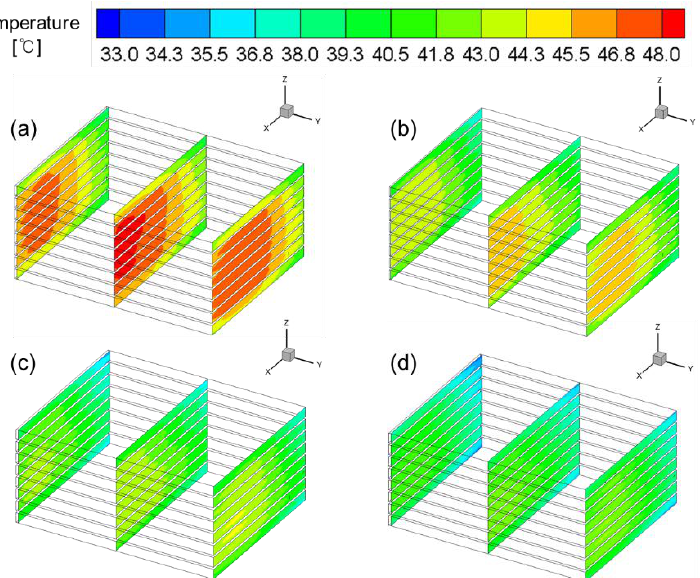
Figure 11. Temperature distributions of the LIB cells within the module at the discharge time of 960 s with the discharge rate of 3 C for the forced convection cooling with the volumetric